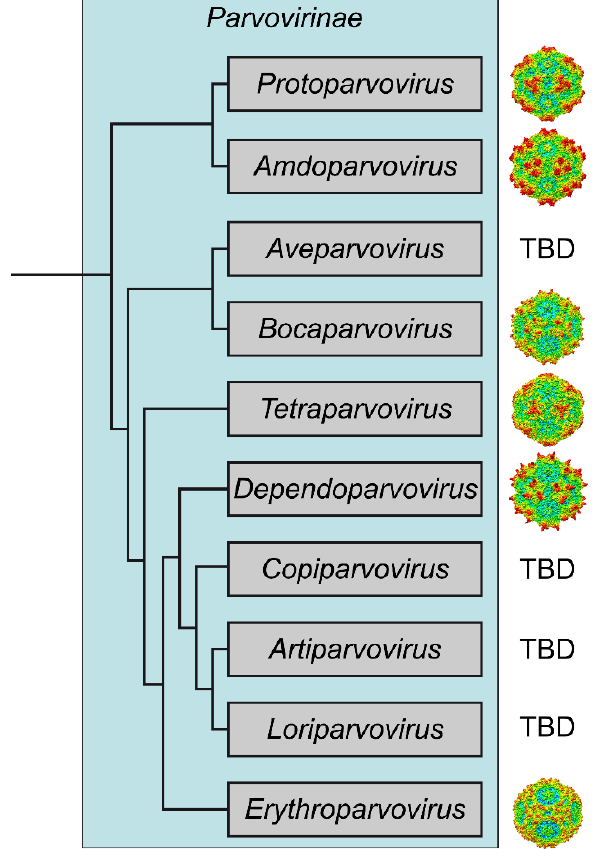
Figure 7. Cladogram of the Parvovirinae subfamily based on Penzes et al. [2]. The representative members of the genera for which capsid structures have been determined are CPV ( Protoparvovirus ), AMDV ( Amdoparvovirus ), HBoV1 ( Bocaparvovirus ), PARV4 ( Tetraparvovirus ), AAV2 ( Dependoparvovirus ), and B19 ( Erythroparvovirus ). Radially colored capsid surface representations (blue to red) are viewed along the two-fold axis and were generated using Chimera [25]. TBD: to be determined.